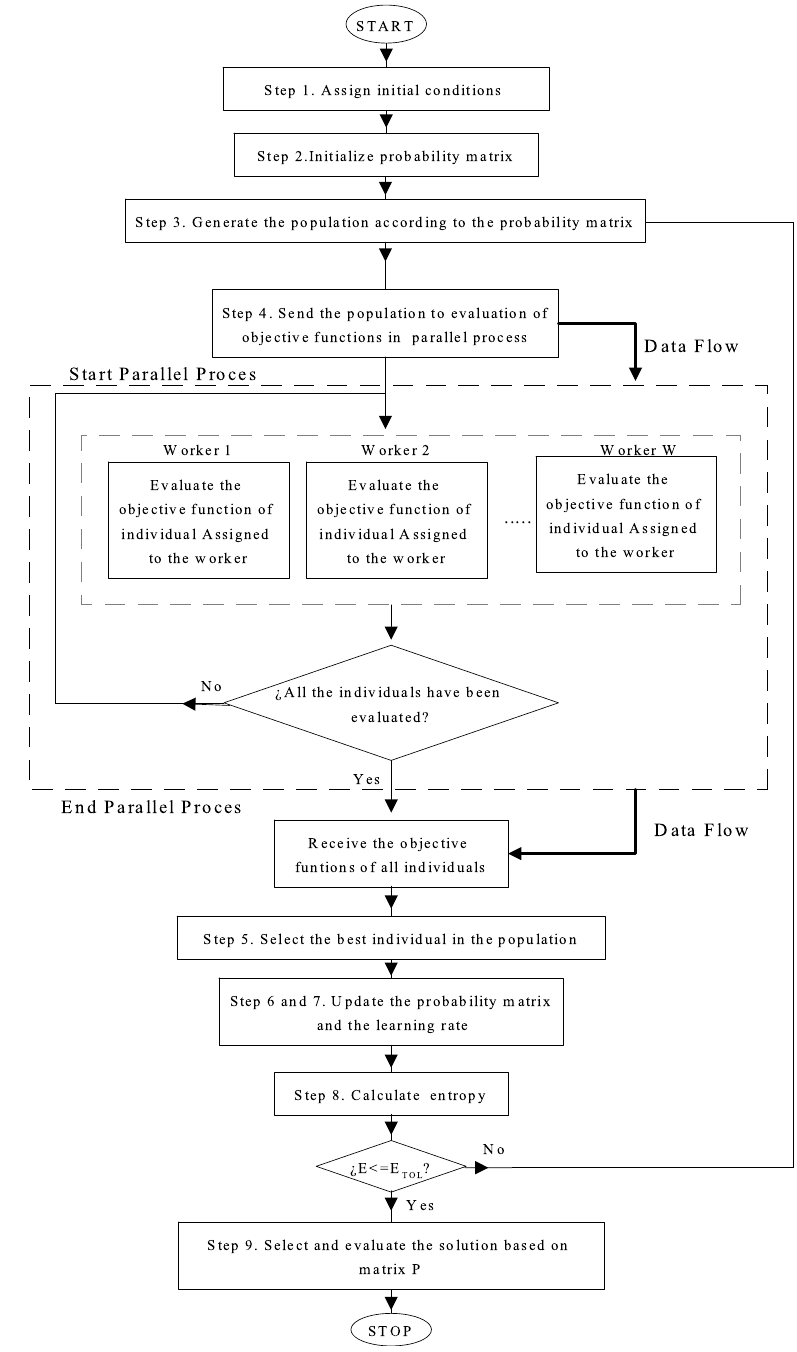
Figure 4. Flowchart of the Parallel PBIL (PPBIL)